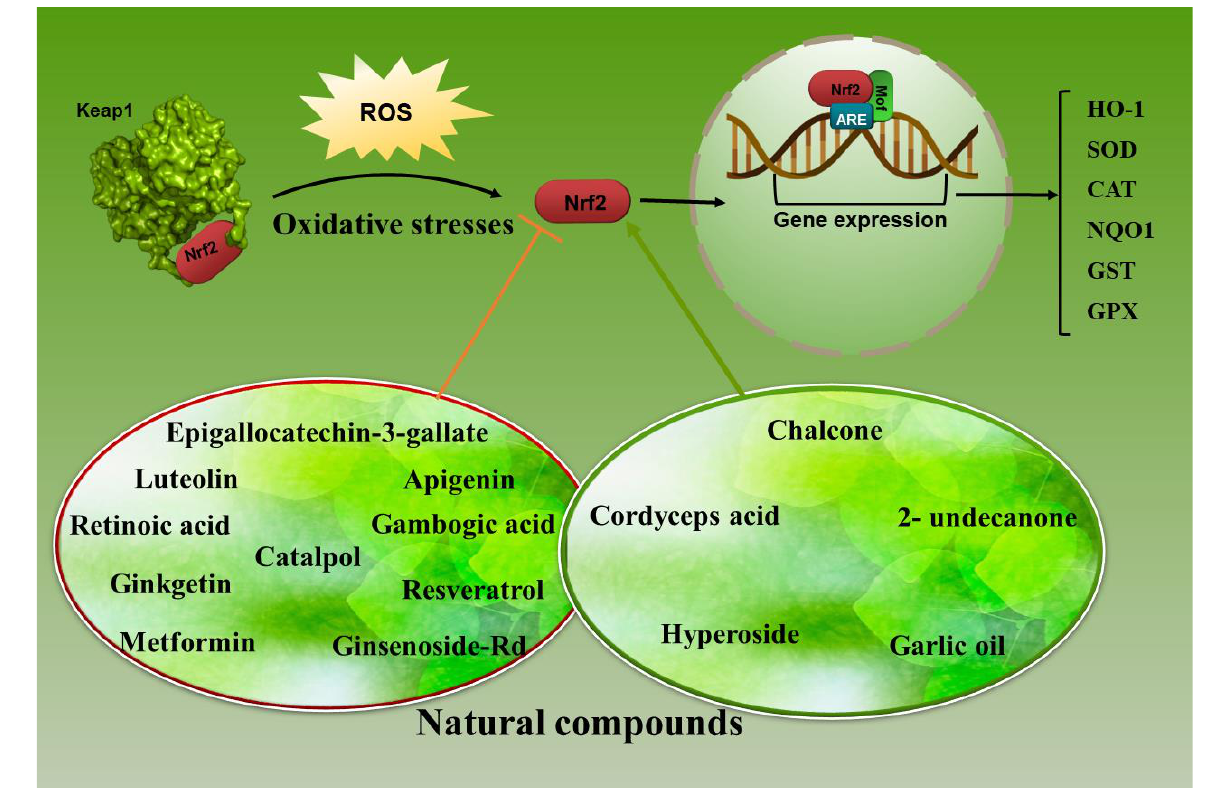
Figure 7. Activation/suppression of the Nrf2-Keap1 pathway and its related genes by various natural compounds has an important role in cancer cell growth and progression.